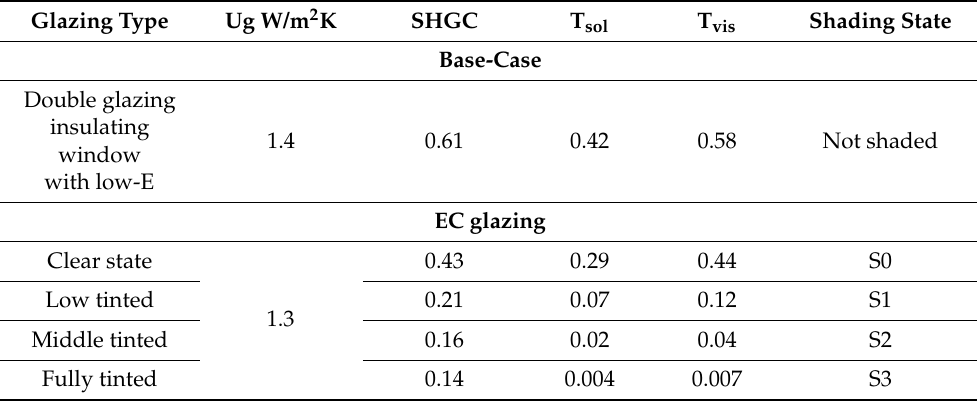
Table 1. Overall performance of EC glazing and base-case calculated by WINDOW (v. 7.6). Glazing